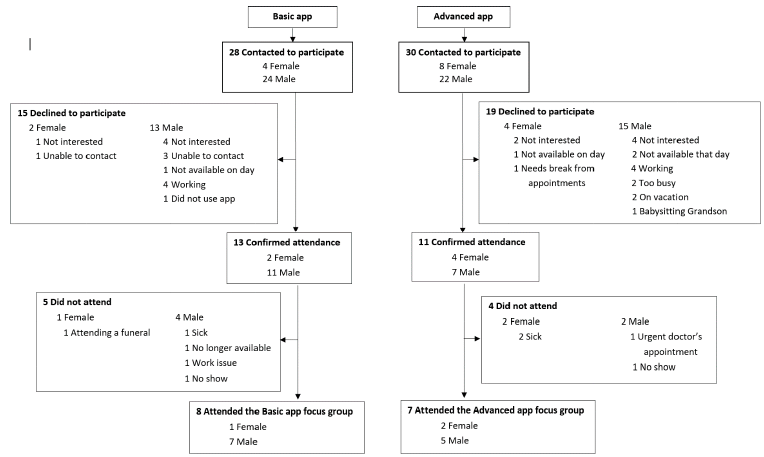
Figure 1. Focus groups participation